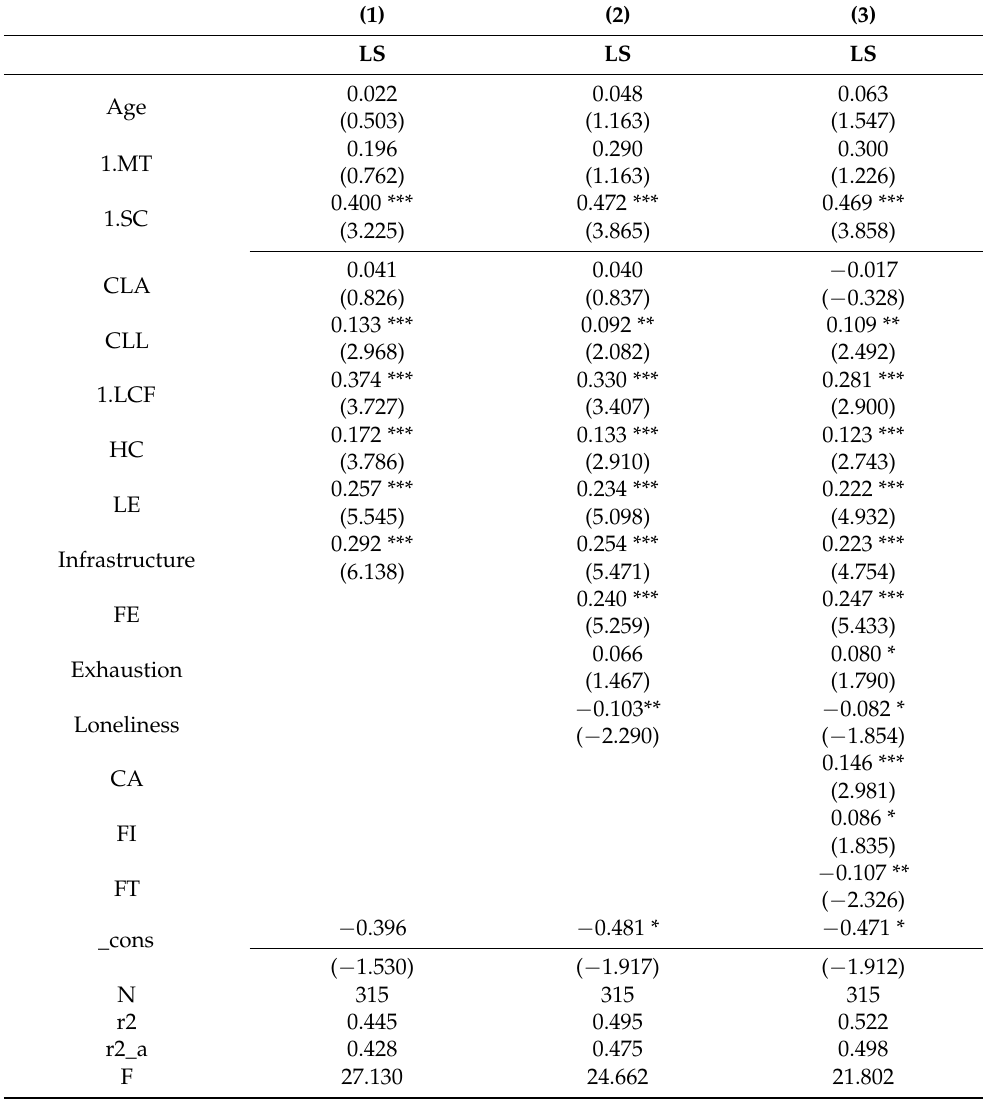
Table 5. Benchmark Regression